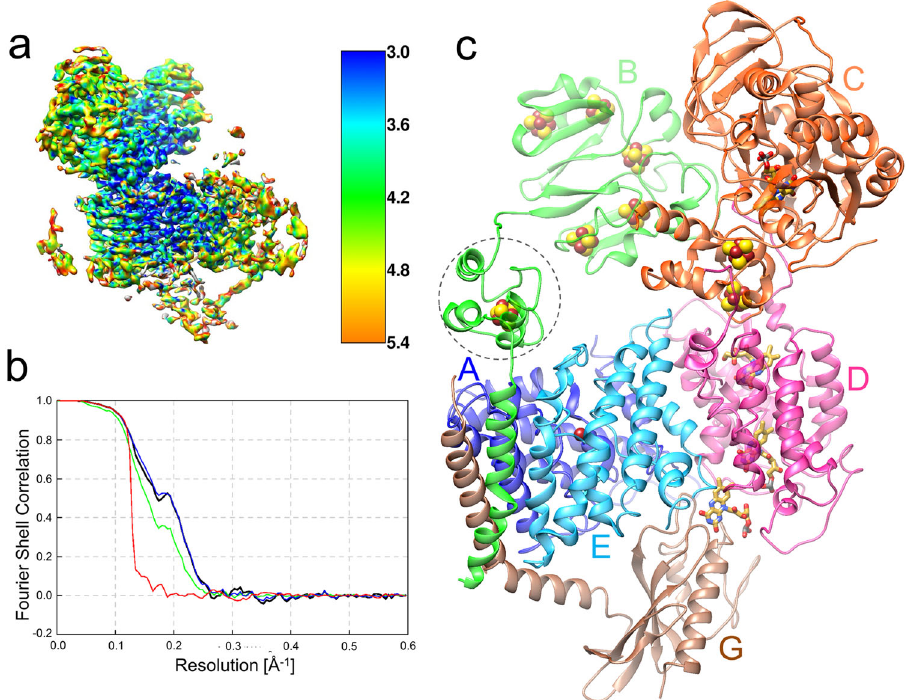
Fig.2| Cryo-EMstructureofRnffrom C.tetanomorphum .a Cryo-EM mapof Rnf color-codedaccordingtothelocalresolution. b Gold-standardFSCplot;bluecurve is FSC-corrected and green curve is FSC-unmasked. Resolution estimated at FSC=0.143. c Ribbon model. The Rnf or RnfABCDEG structure consists of membrane-spanningRnfADE(blueA,pinkD,skyblueE),extracellularRnfG(brown G), and cytoplasmic RnfB (green B) and RnfC (orange C). RnfB and RnfG contain